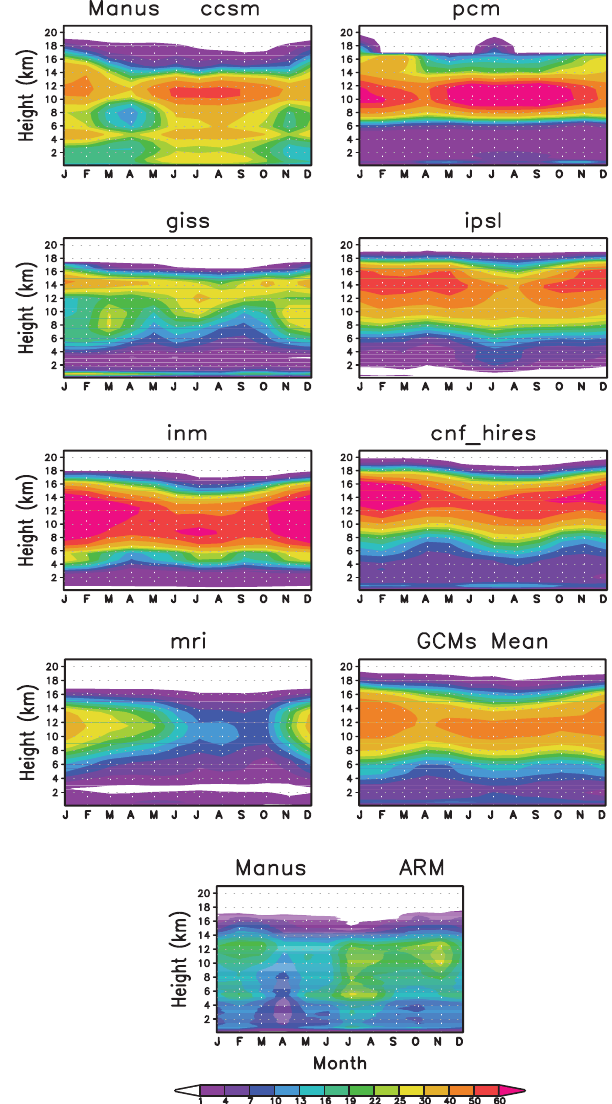
Fig. 10. The monthly mean time-height plots of cloud fraction (CF) from ARSCL observation and GCMs over